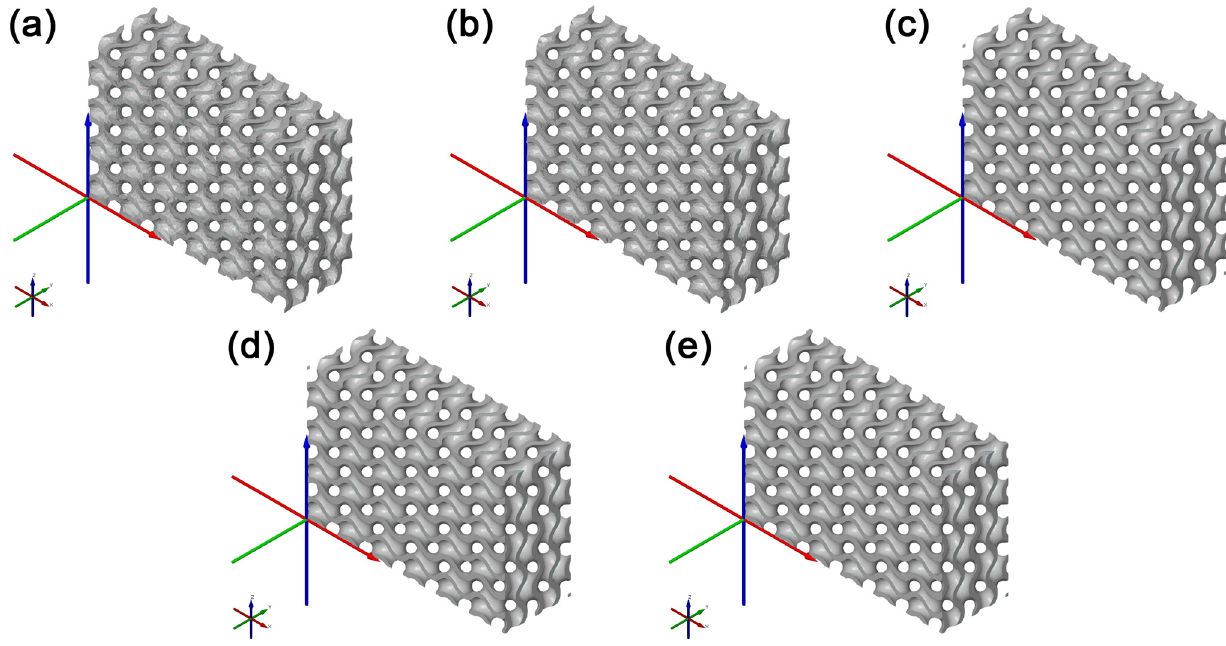
Figure 2. Tessellated models of cellular structures of different accuracies captured in GOM Inspect. ( a ) model Very Low, ( b ) model Low, ( c ) model Medium, ( d ) model High, and ( e ) model Very High.